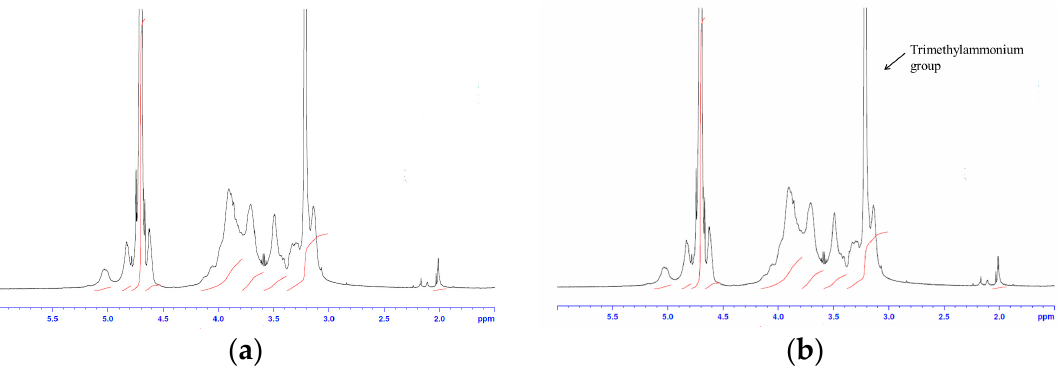
Figure 1. 1 H-NMR spectra of ( a ) chitosan and ( b ) HTCC at 25 °C.